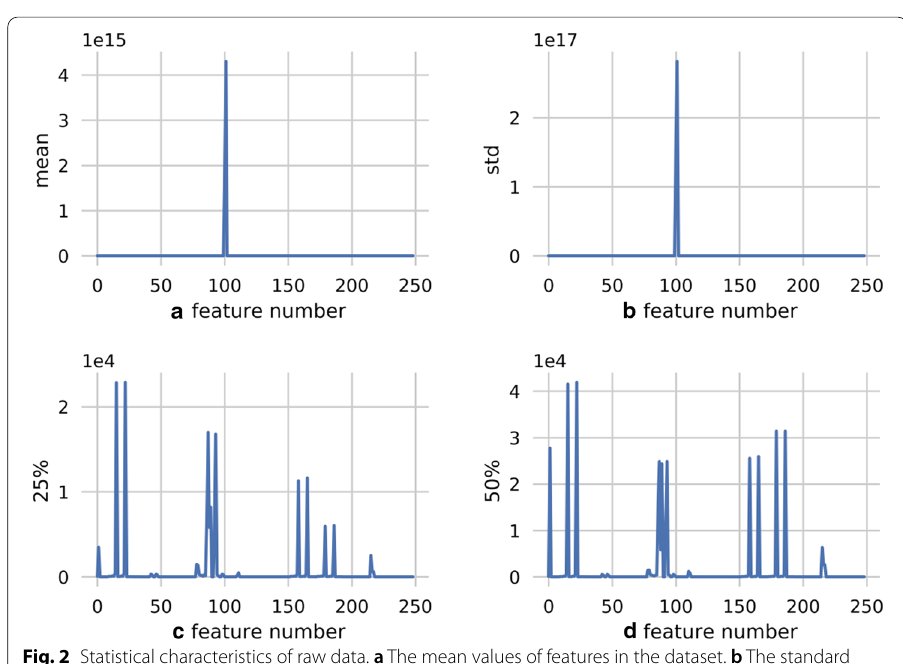
Fig. 2 Statistical characteristics of raw data. a The mean values of features in the dataset. b The standard deviation of features in the dataset. c The 25% quartile values of features in the dataset. d The 50% quartile values of features in the